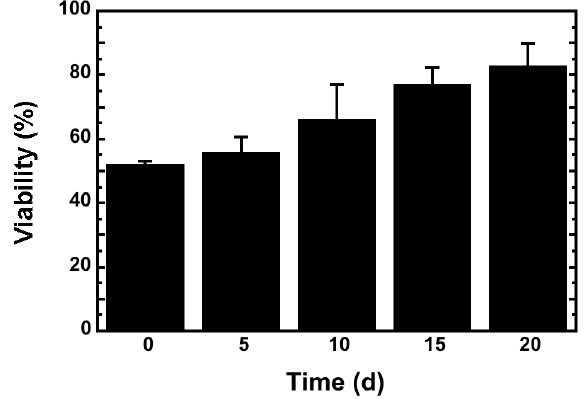
Figure 5. Viability of microencapsulated EDX cells at various time points (days) up to 20 days after microencapsulation.